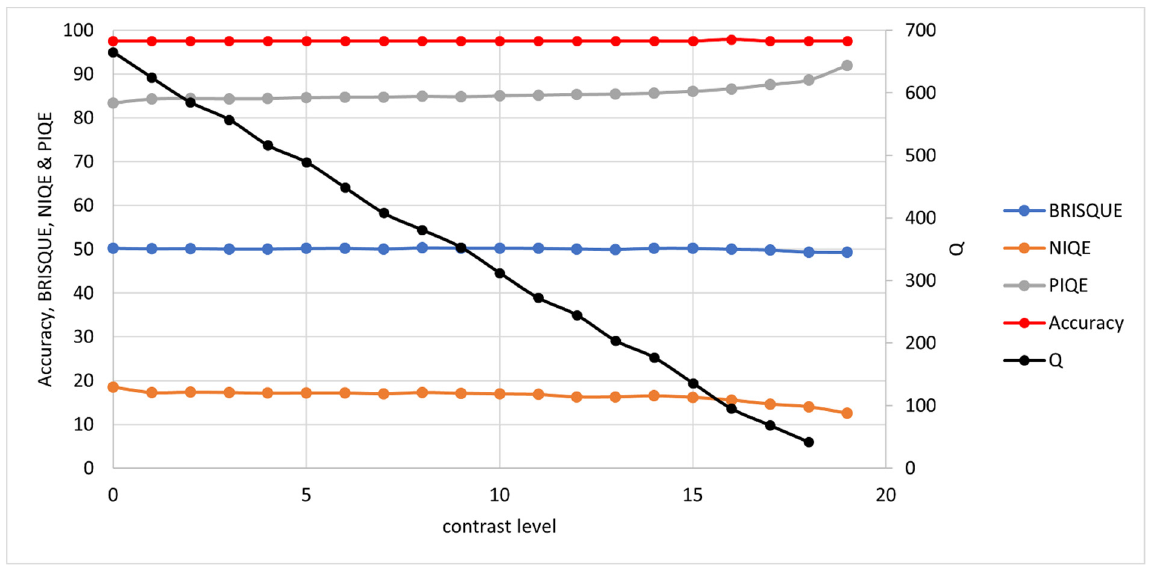
Figure 7. OCR Accuracy and Quality Metrics vs. Contrast Level. Note: high BRISQUE, NIQE and PIQE values denote low quality while high Q values denote high quality. Again, a separate axis is used for Q here as the unnormalized Q value tends to be considerably higher than the other NR-IQAs, which tend to stay in the range 0 to 100.